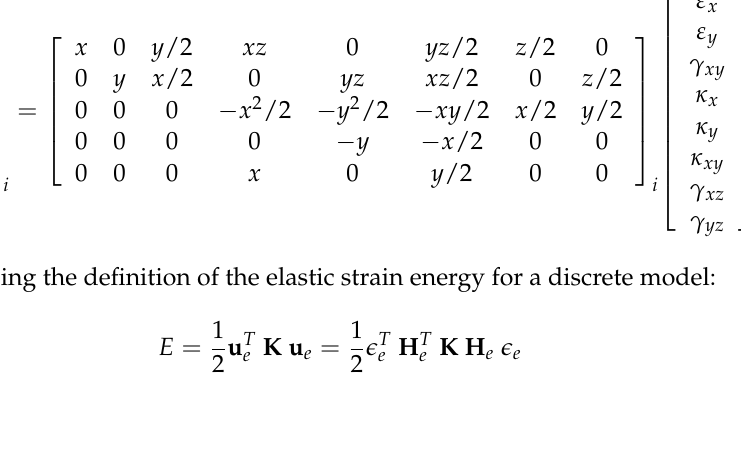
Figure 10. RVE—external (in red color) and internal nodes and finite elements: ( a ) SW model; ( b ) DW model. ( b ) DW